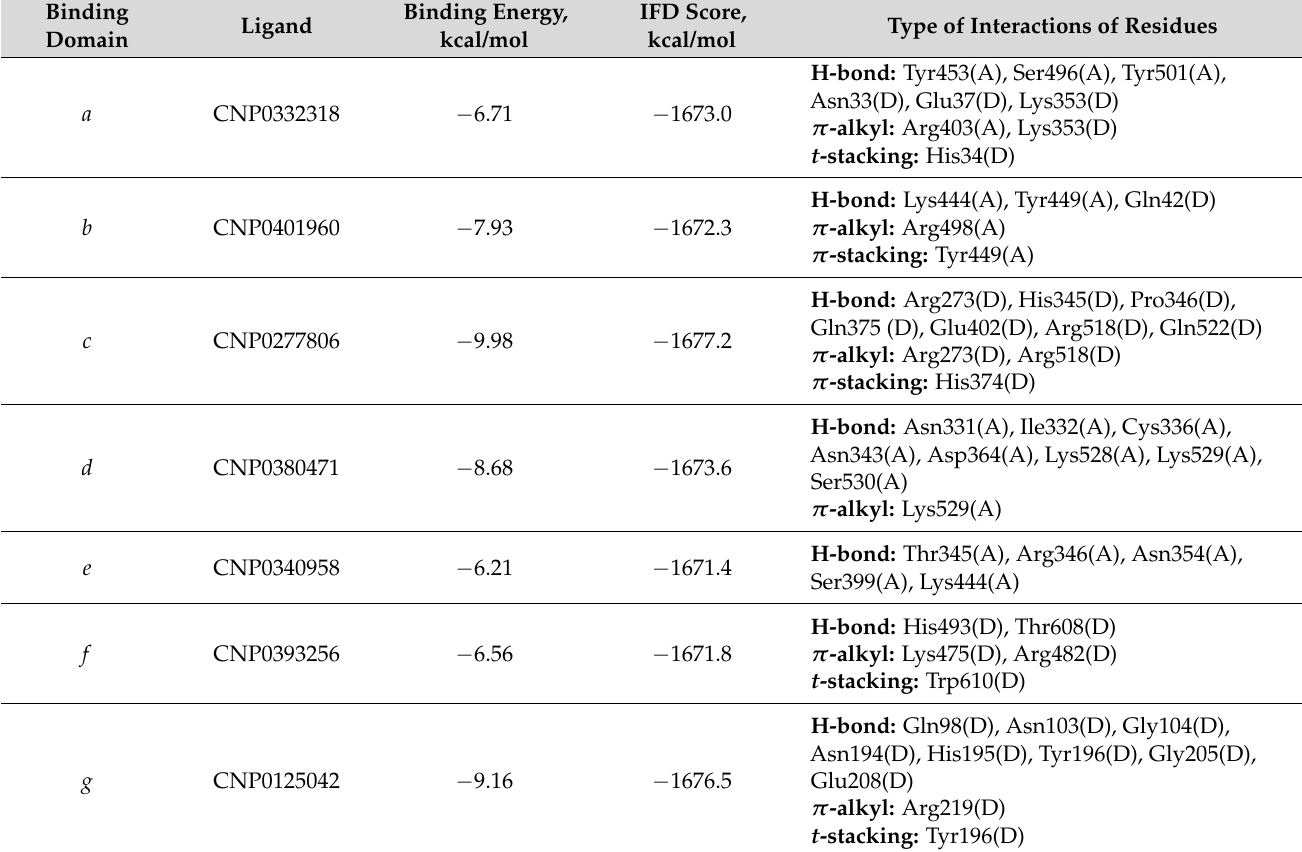
Table 4. Induced Fit Docking results for the SARS-CoV-2 RBD–ACE2 of top